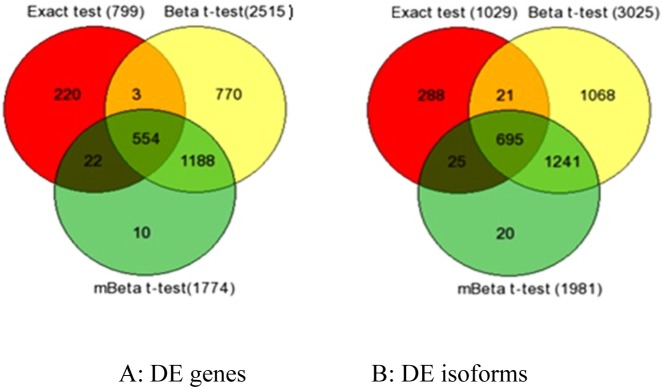
Differential Expression Venn diagram.Numbers of edgR Exact test findings, Beta t-test findings and mBeta t-test findings are listed in red, yellow and green cycles, respectively. In DE genes (A) and DE isoforms (B), 98% of mBeta t-test findings are the same with Beta t-test findings, the edgeR Exact test method has about 70% of findings that overlap with Beta t-test and mBeta t-test findings.